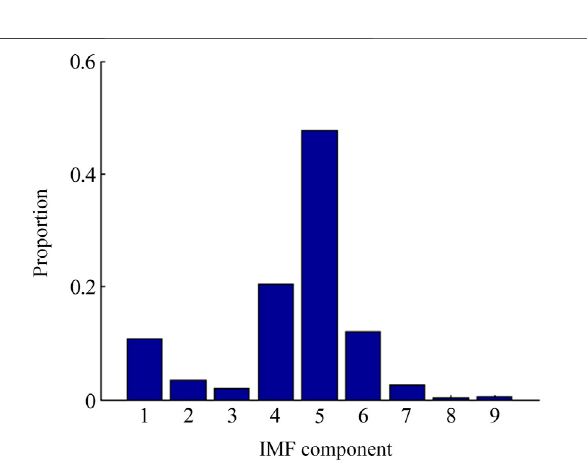
FIGURE 8 | Different IMF components decomposed by EMD.